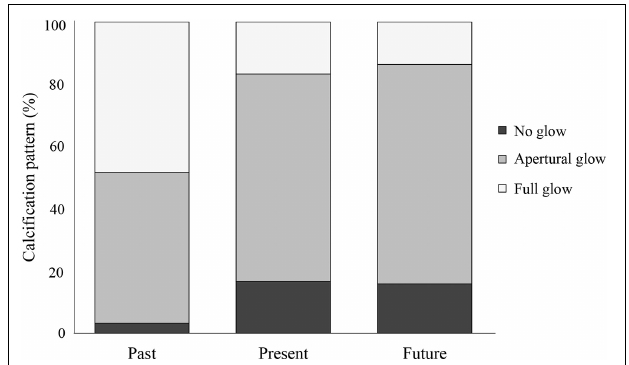
FIGURE 3 | Calcification patterns in the pteropod population after exposure to past, present, and near-future conditions, expressed as percentage of the population that shows no glow (black), apertural glow (gray), and full glow (light gray) (31–44 individuals per treatment), see also Figure 2 .